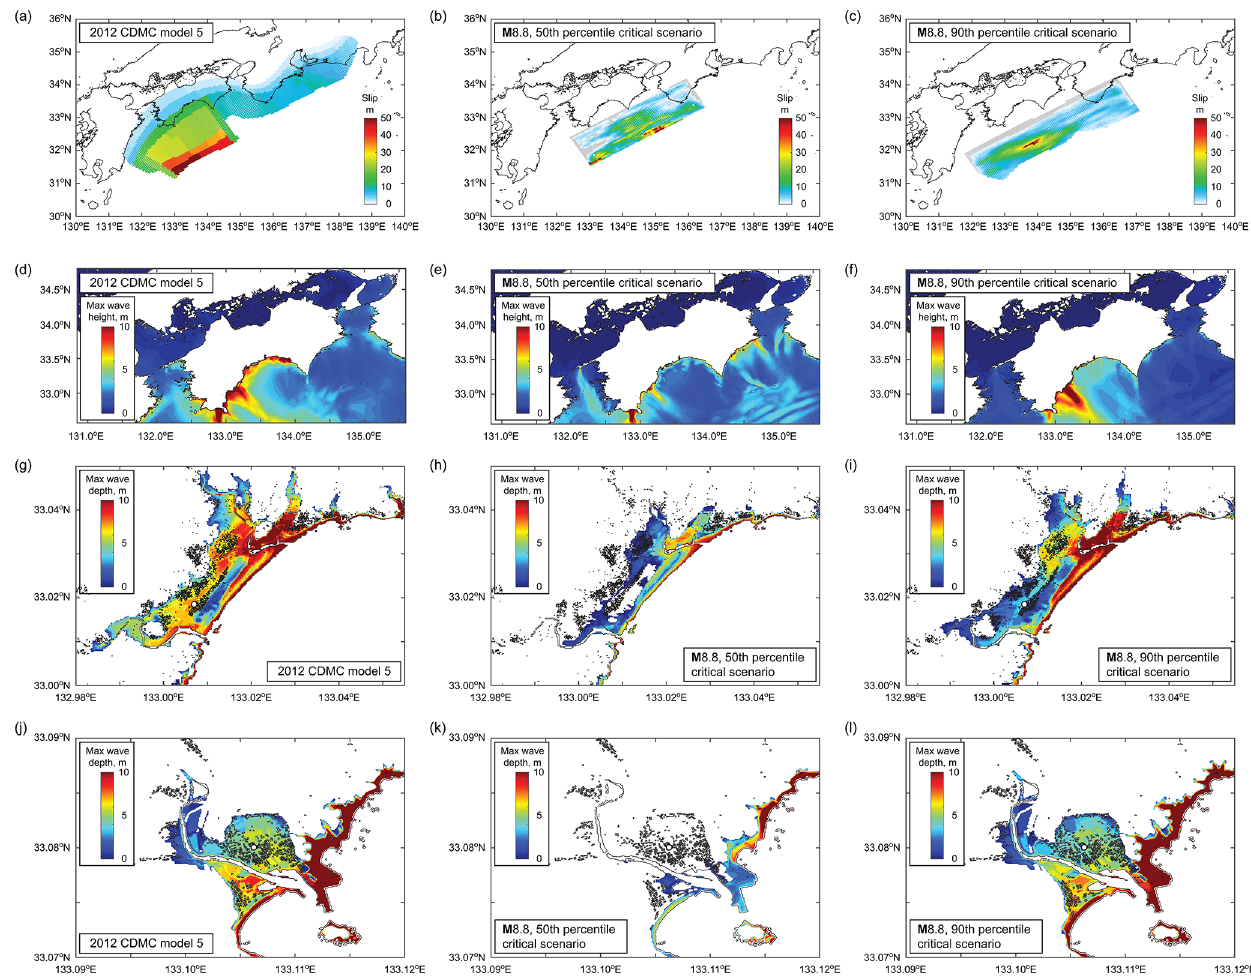
Figure 14. Critical tsunami hazard scenarios for the Ogata and Saga districts for the M 8.7–8.9 magnitude range. Panels (a, d, g, j) correspond to the most critical scenario based on the 2012 CDMC models (i.e., model 5). Panels (b, e, h, k) and (c, f, i, l) correspond to the 50th and 90th percentiles of inundation areas in the Oagata and Saga districts (Fig.